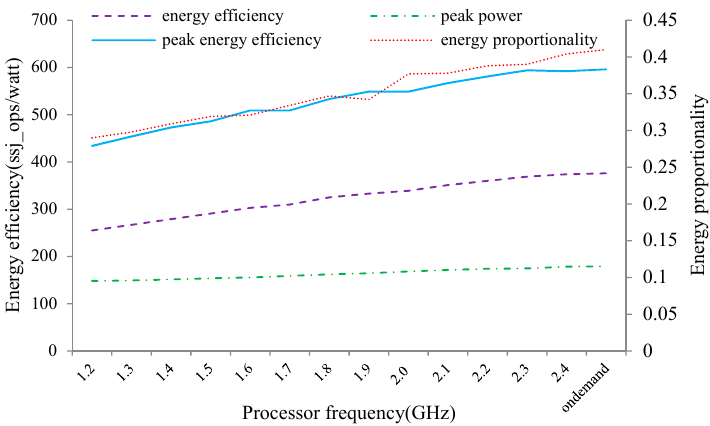
Figure 18. Server #3 energy efficiency and proportionality under different frequency scaling configurations. Table 9. Power consumption and performance comparison of heterogeneous cluster.